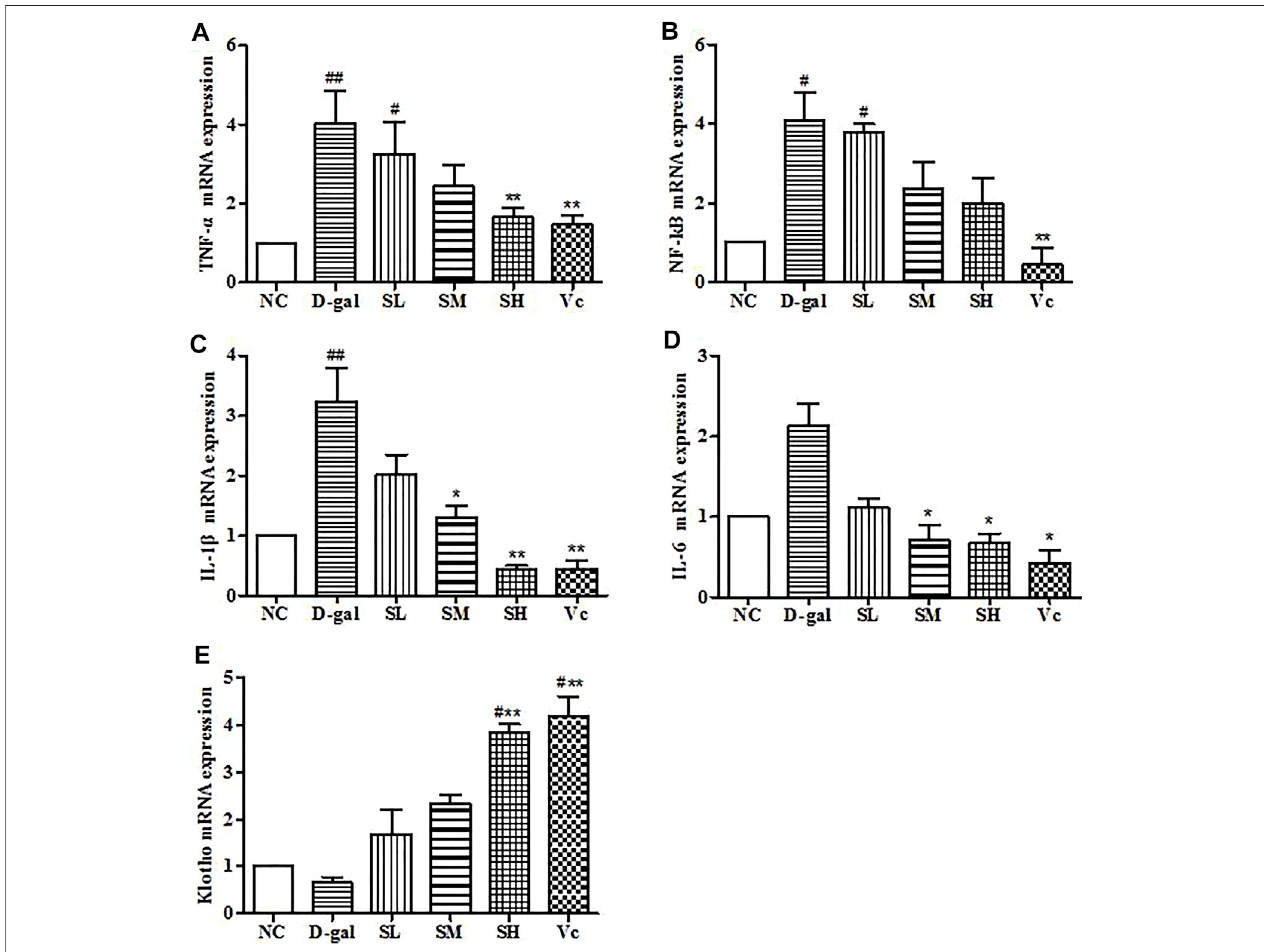
FIGURE 10 | mRNA levels of TNF – α , NF – kB, IL – 1 β , IL – 6 and Klotho in mice brain. Compared with normal group, #: p < 0.05, ##: p < 0.01; Compared with D – gal group, *: p < 0.05, **: p < 0.01. NC: normal control group; D – gal: D – gal model group; SL: low – dose SDE group; SM: medium – dose SDE group; SL: high – dose SDE group; Vc: Vc positive control